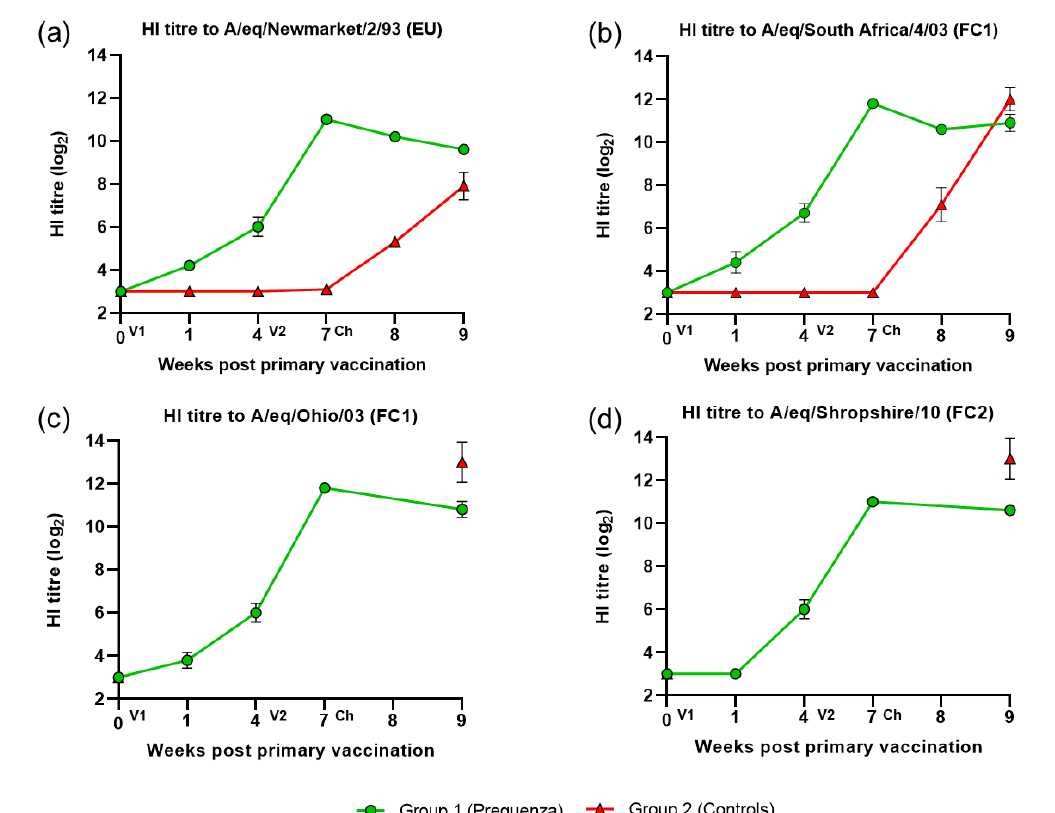
Figure 1. Mean hemaglutination inhibition (HI) antibody titre response in group 1 and 2 against H3N8 EIV ( a ) A/equine/Newmarket/2/93, ( b ) A/equine/South Africa/4/03 (FC1), ( c ) A/equine/Ohio/03 (FC1), and ( d ) A/equine/Shropshire/10 (FC2). Week 0, V1; Week 4, V2; Week 7, virus challenge (VC). Green square = group 1, Equilis Prequenza vaccinated group; red triangle = group 2, unvaccinated control group. Error bars represent SEM. A titre of <4 was converted to three for graphical presentation. Table 2. Inferential statistics: comparison of the rectal temperature, clinical observations, and viral shedding between groups after challenge (mean effect between 1 and 14 dpc a or 1 and 7 dpc b ). Group Comparison 1 = Control, 2 = Equilis Prequenza Parameter 2 vs. 1 Rectal temperature over time a 0.0156 Peak change rectal temperature post-challenge a 0.0478 Clinical score a <0.0001 Total clinical score a <0.0001 Viral shedding nasal swabs +/− b <0.0001 Viral shedding nasal swab titre b <0.0001